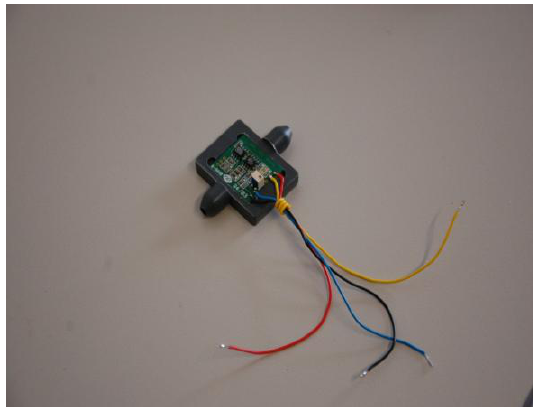
Figure 5. Picture of the full meter comprising the housing and the PCB with the electronics and the sensor on it mounted on the